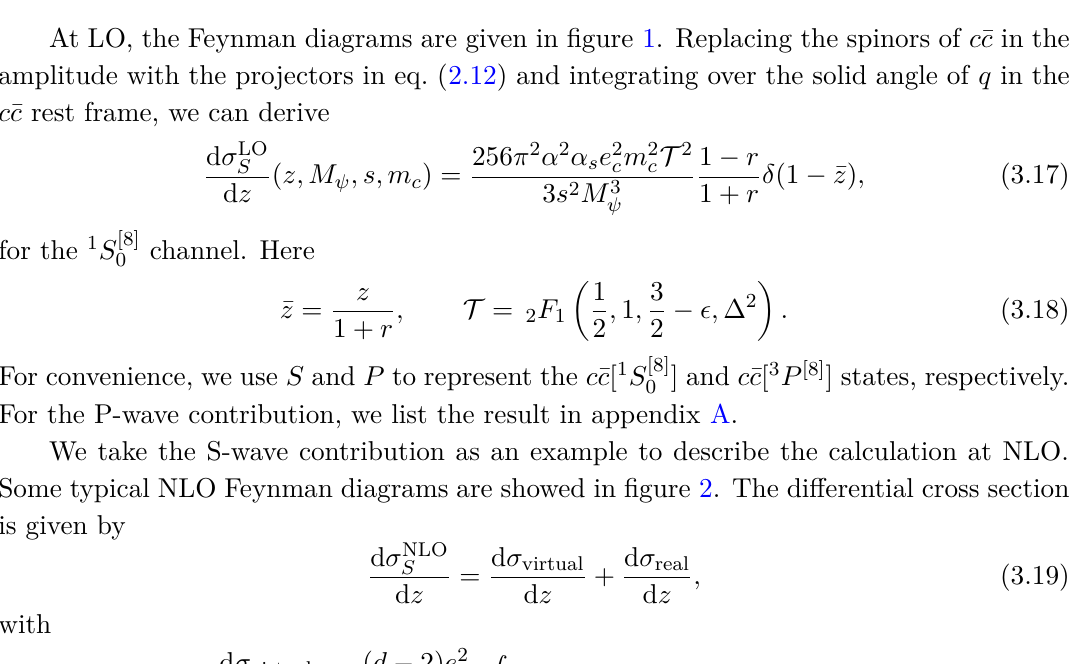
] production from e + e − annihi- 0